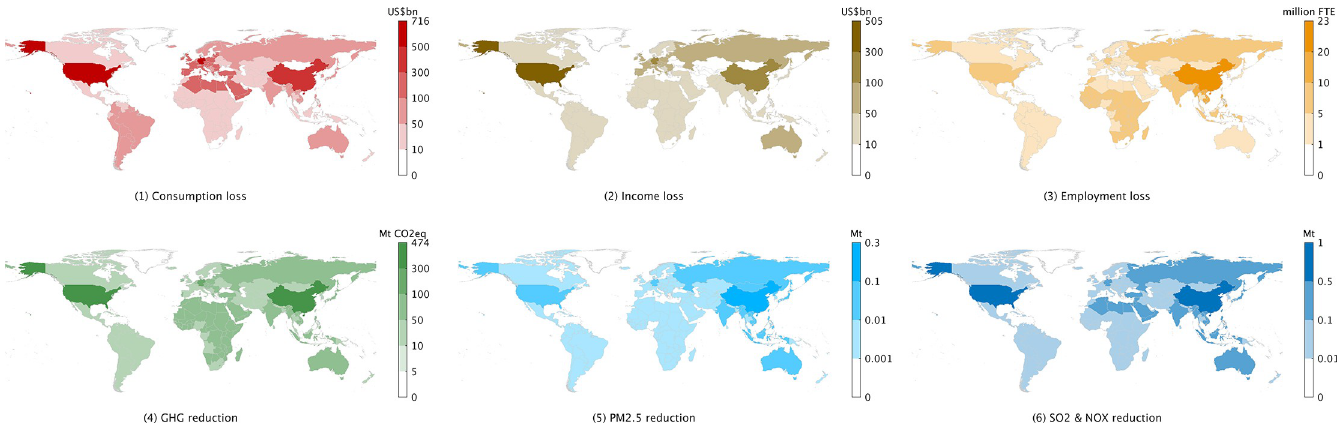
Fig 1. Global impacts from the COVID-19 pandemic broken down by world region. Accompanying data tables are in SI 6.1 in S1 File.